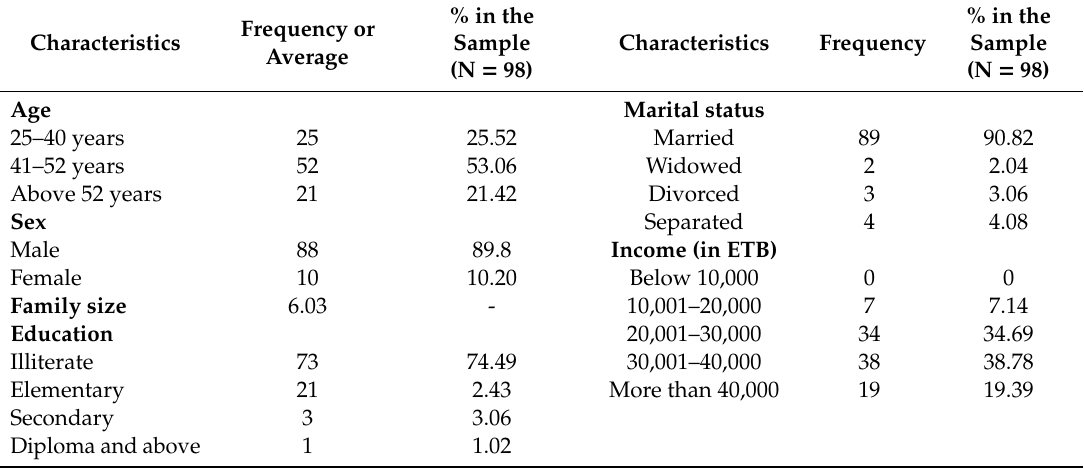
Table 1. Main demographic and socioeconomic characteristics of sample